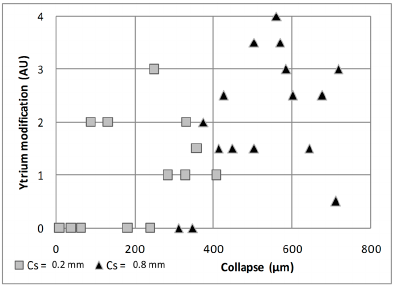
Figure 10. Yttrium modification (arbitrary unit defined in Table 3) as a function of collapse value.